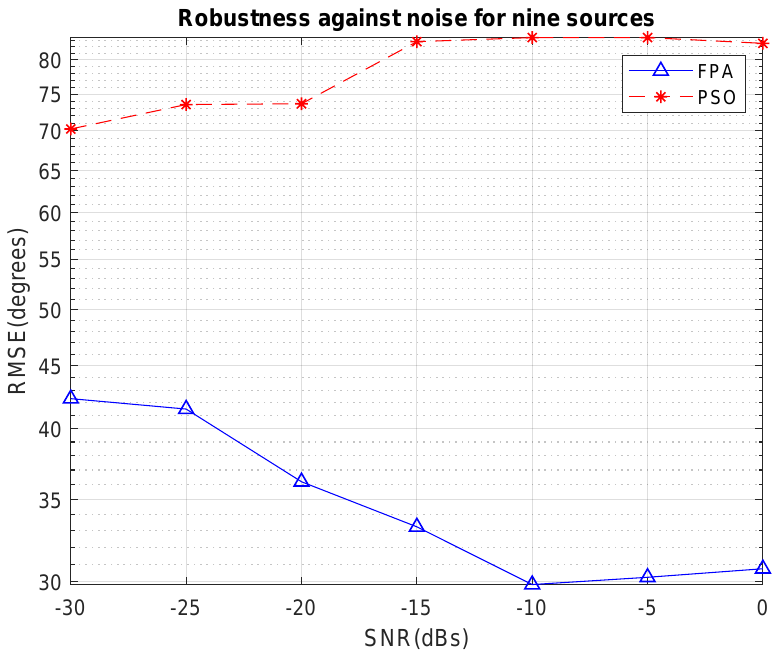
Figure 5. Robustness against noise for nine targets.